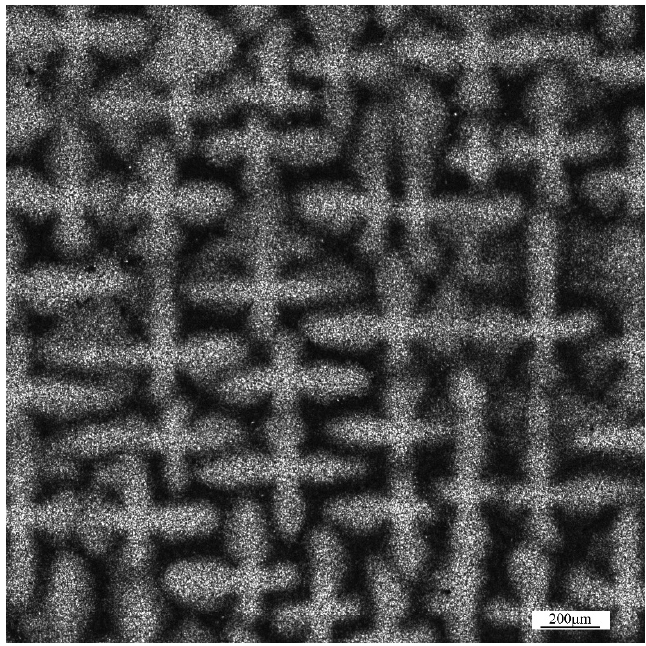
Figure 1. HT901 metallographic image.